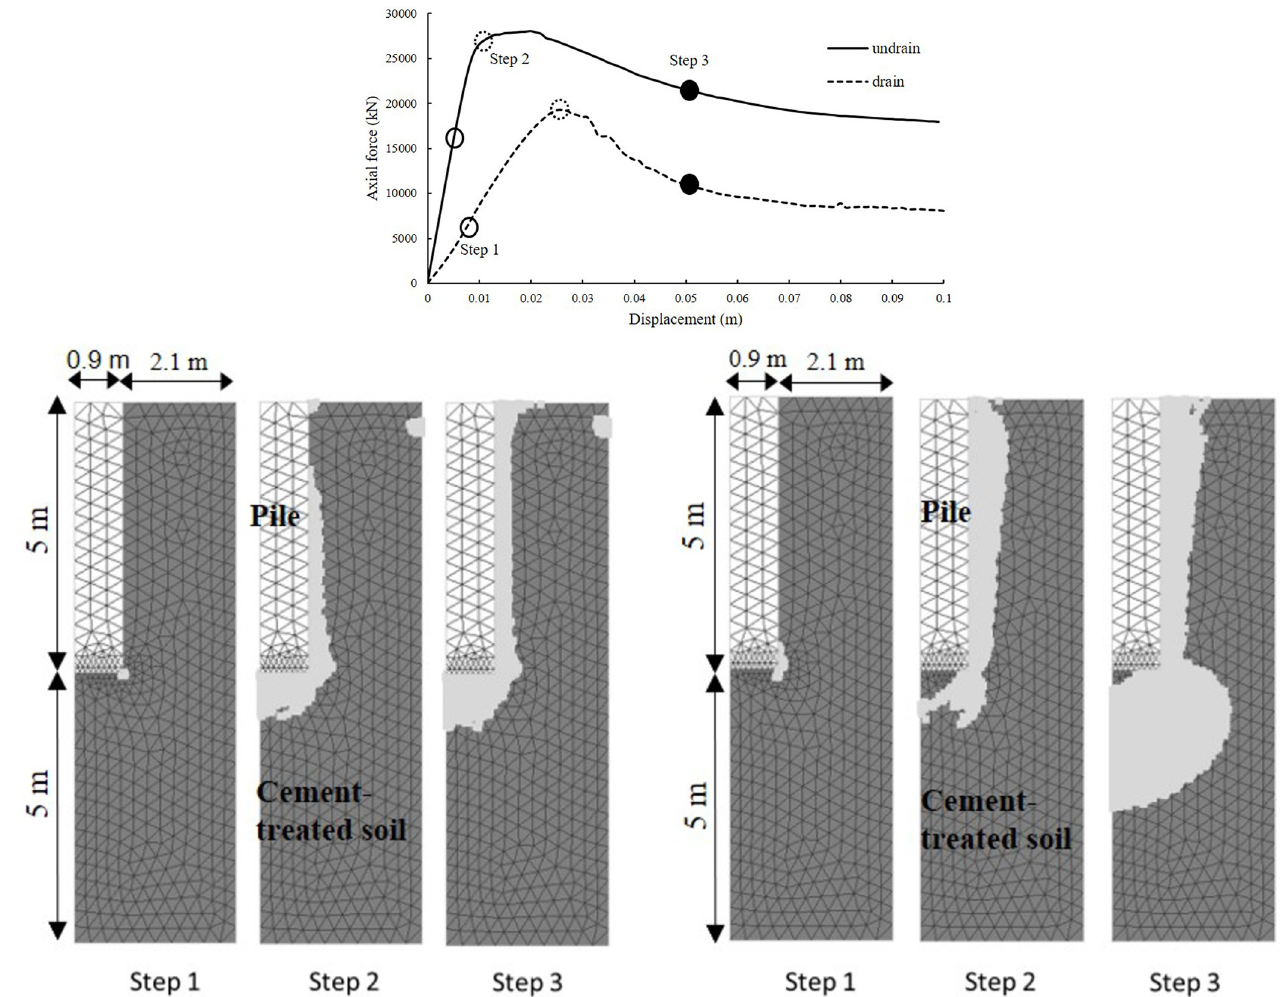
Fig 2. Deterministic analysis: (a) the resistance-displacement curve for pile embedded in cement-treated soil in undrained and drained conditions (b) the corresponding soften status at different step in drained condition (c) the corresponding soften status at different step in undrained